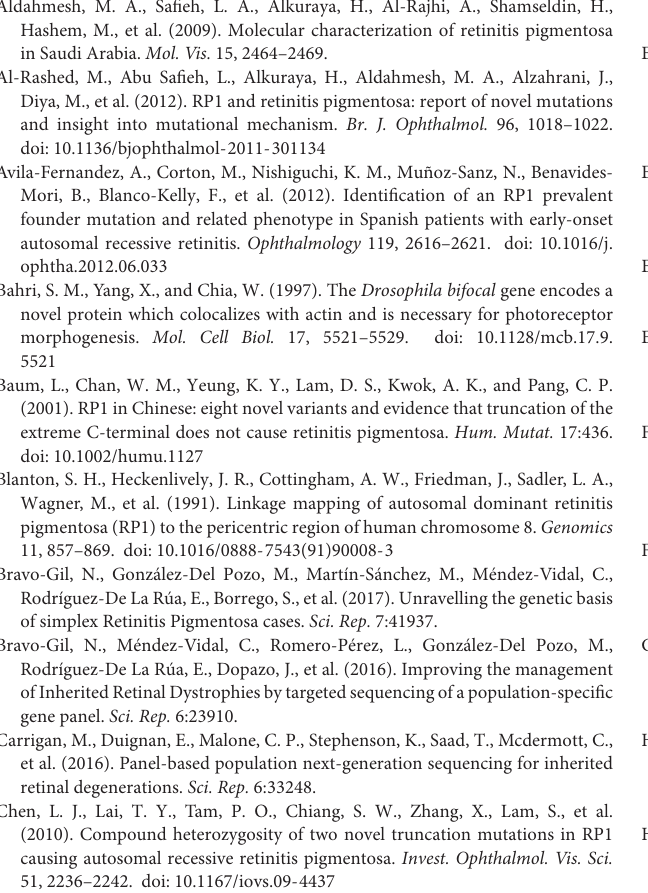
the missense variants in the published literature. (C) Distributions and frequencies of the missense variants in this study. Supplementary Table 1 | Clinical information of probands with RP1 variants in our cohort. Supplementary Table 2 | Biallelic variants in RP1 not associated with RP. Supplementary Table 3 | Single heterozygous truncation variants in RP1 that were not associated with RP in our cohort. Supplementary Table 4 | Truncation RP1 variants in published literature. Supplementary Table 5 | All missense RP1 variants in published literature. Supplementary Table 6 | Truncation variants in RP1 reported in patients with conflict pattern of